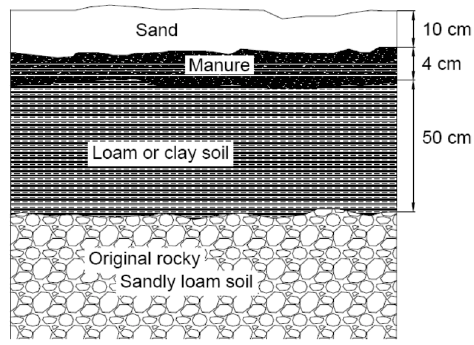
Figure 2. “ Enarenado ” experiment details.